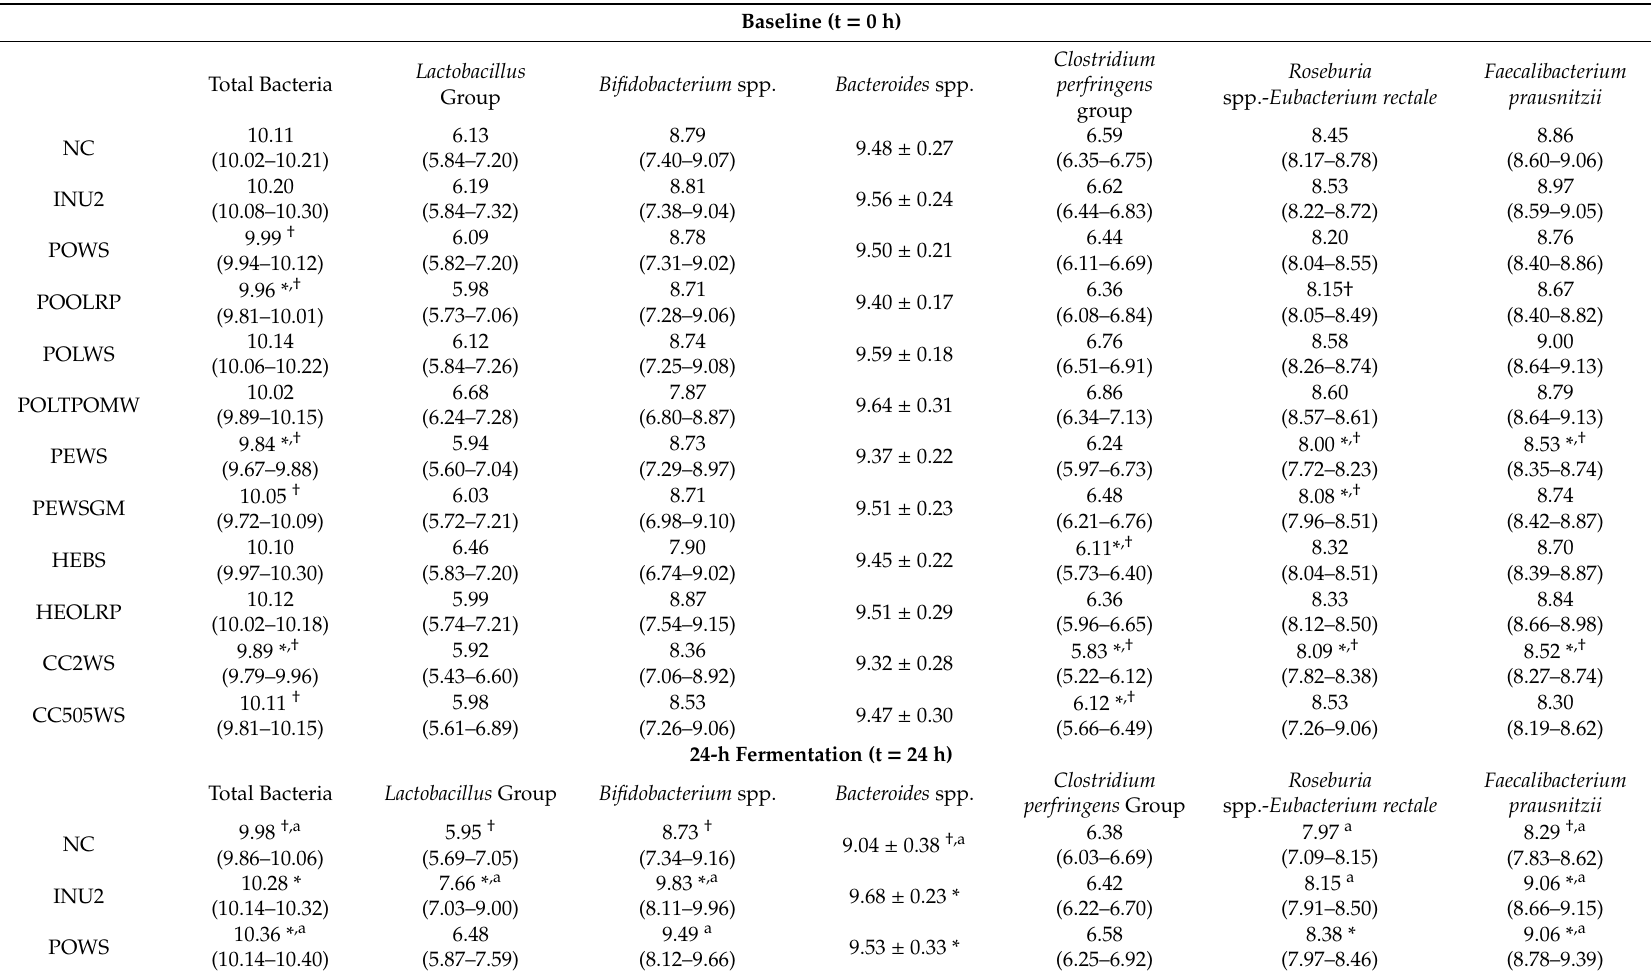
Table 3. Fecal microbial quantification (quantitative PCR (qPCR); log 10 copies of 16S rRNA gene mL − 1 of sample) at baseline (t = 0 h) and after 24 h